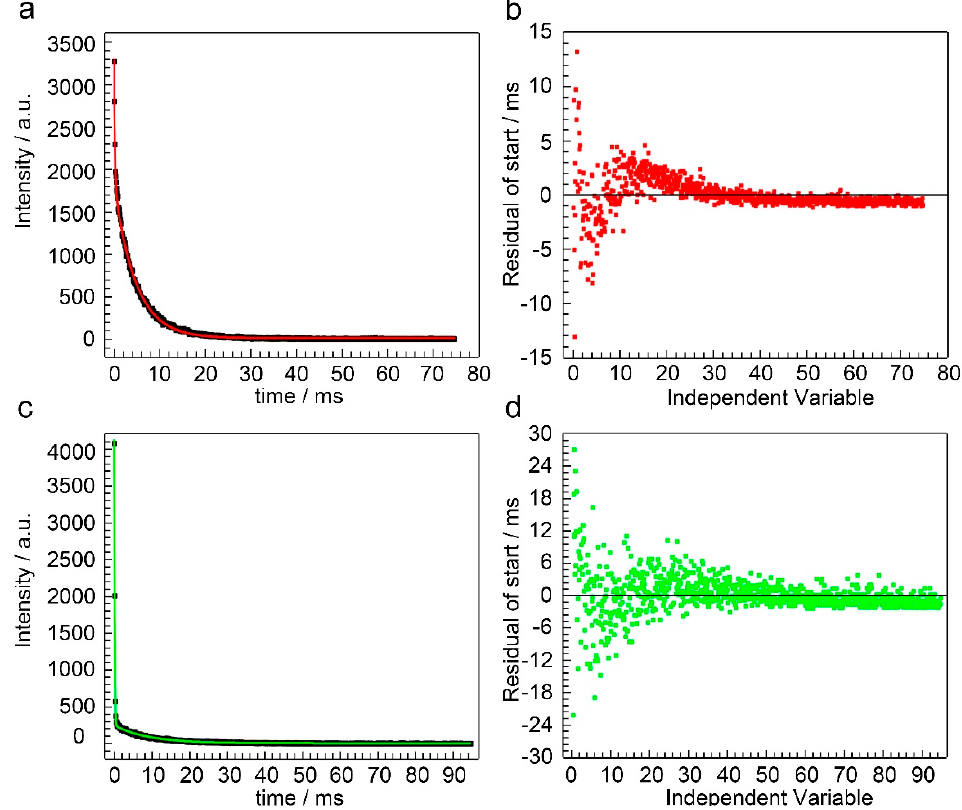
Figure 6. Luminescence decay curve of poly-Eu(III) ( a , b ) and poly-Tb(III) ( c , d ) (in CH 3 OD at 77 K).